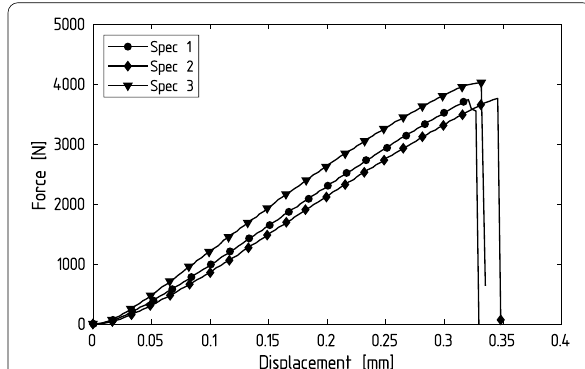
Figure 14 Load‑displacement curve of out‑of‑plane tensile tests